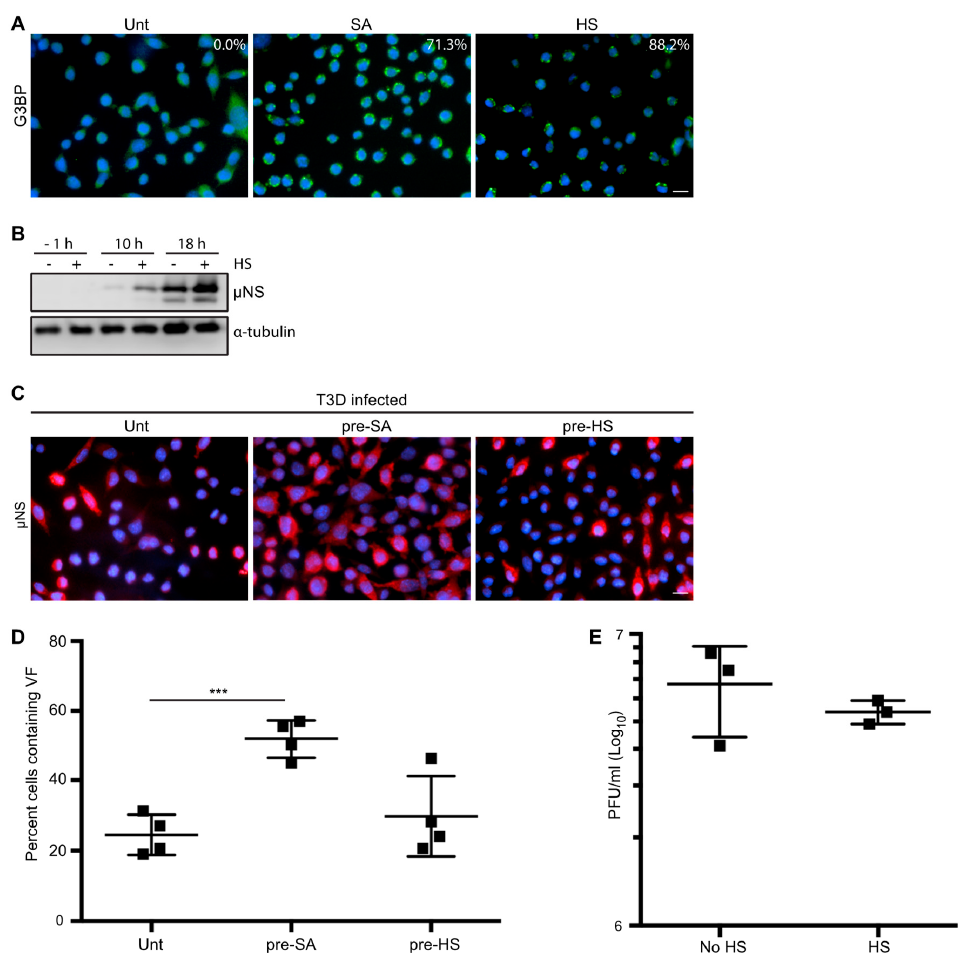
Figure 4. Heat shock (HS) enhances reovirus protein expression, but not virus yield, in L929 cells. ( A ) L929 cells were left untreated (Unt), were pre-treated with 0.5 mM sodium arsenite (SA), or were HS at 44 ◦ C for 45 min (HS) before fixing and immunostaining for G3BP (green) to detect SGs. The percentage of SGs induced was quantified ((# of cells containing SGs / total # of cells) × 100) from three independent experiments. ( B ) L929 cells were left untreated or were HS as in (A) before infection with T3D at an MOI = 1. At the indicated time points, cells were lysed and the expression levels of the indicated proteins were determined by immunoblot. ( C ) L929 cells were left untreated, treated with 0.5 mM SA for 30 min, or were HS as in (A) before infection with T3D at an MOI = 1. At 18 h p.i., cells were fixed and immunostained for µ NS (red) and DAPI (nuclei, blue). ( D ) The percent cells containing VFs as represented in panel (C) was quantified ((# of cells containing VF / total # of cells) × 100) from at least three independent experiments. ( E ) L929 cells were left untreated or were HS as in (A) prior to being infected with T3D at an MOI = 1. At 18 h p.i., cells were subjected to the standard reovirus plaque assay in L929 cells and plaques were counted from three independent experiments. *** p < 0.001; two-tailed unpaired t test. The error bars indicate S.D. Scale bars, 50 µ